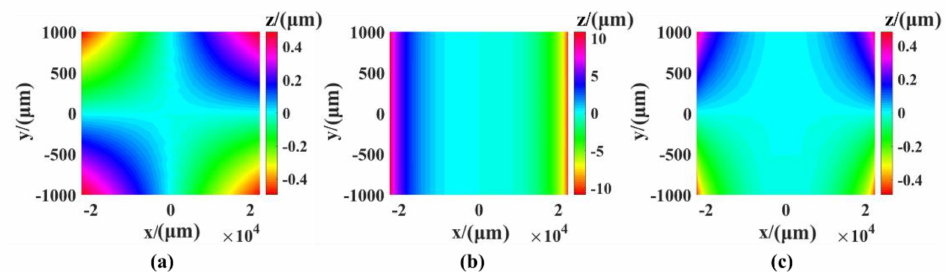
Figure 4. The shape error caused by the perpendicularity error: ( a ) XY perpendicularity error, ( b ) XZ perpendicularity error, ( c ) YZ perpendicularity error.